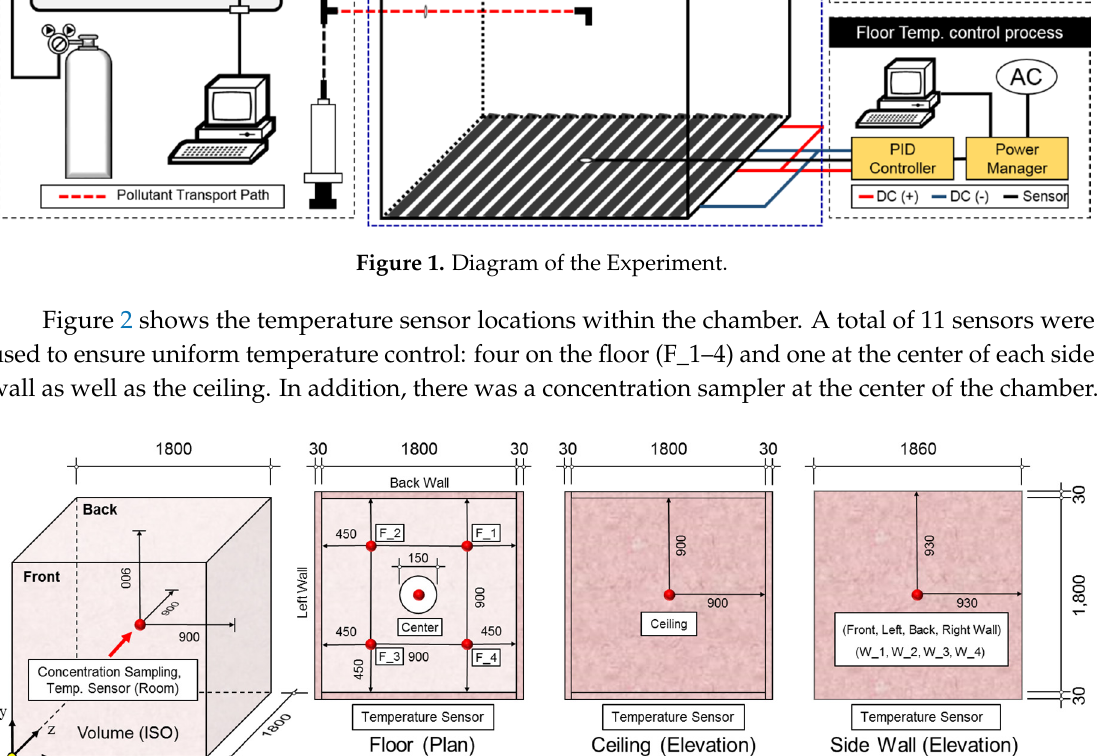
Figure 1. Diagram of the Experiment.